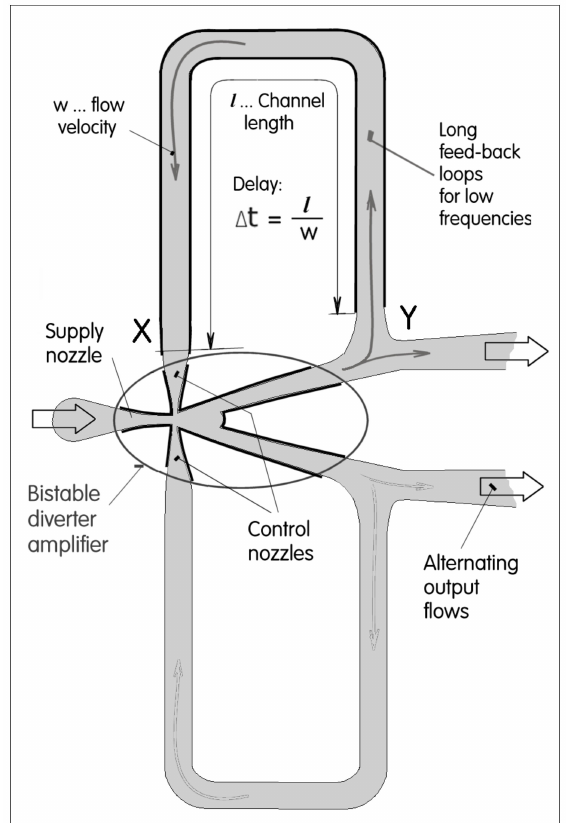
Figure 15. Typical example of oscillator with flow time delays according to Warren’s U.S. patent [15]. The frequency of generated oscillation depends on the lengths of negative feedback loops with the connecting channels between the control X and output Y terminals of a bistable jet-deflection type